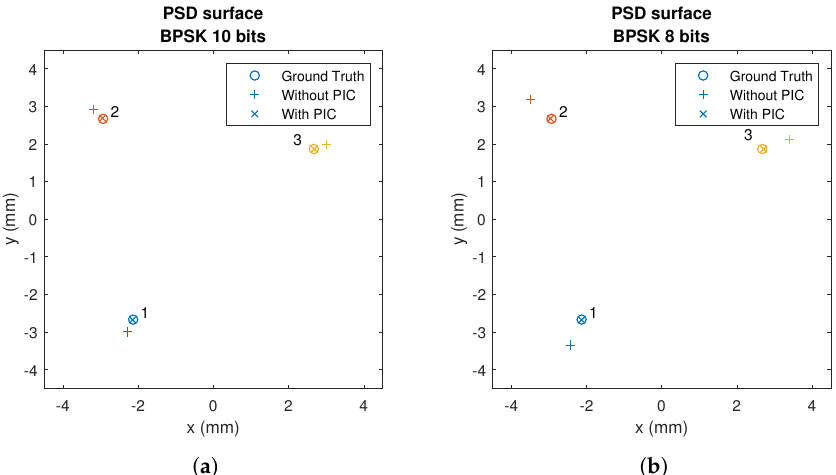
Figure 16. Impact points on the PSD of the five emitters using CDMA-BPSK before and after applying the PIC correction with sizes of: ( a ) 10 bits; and ( b ) 8